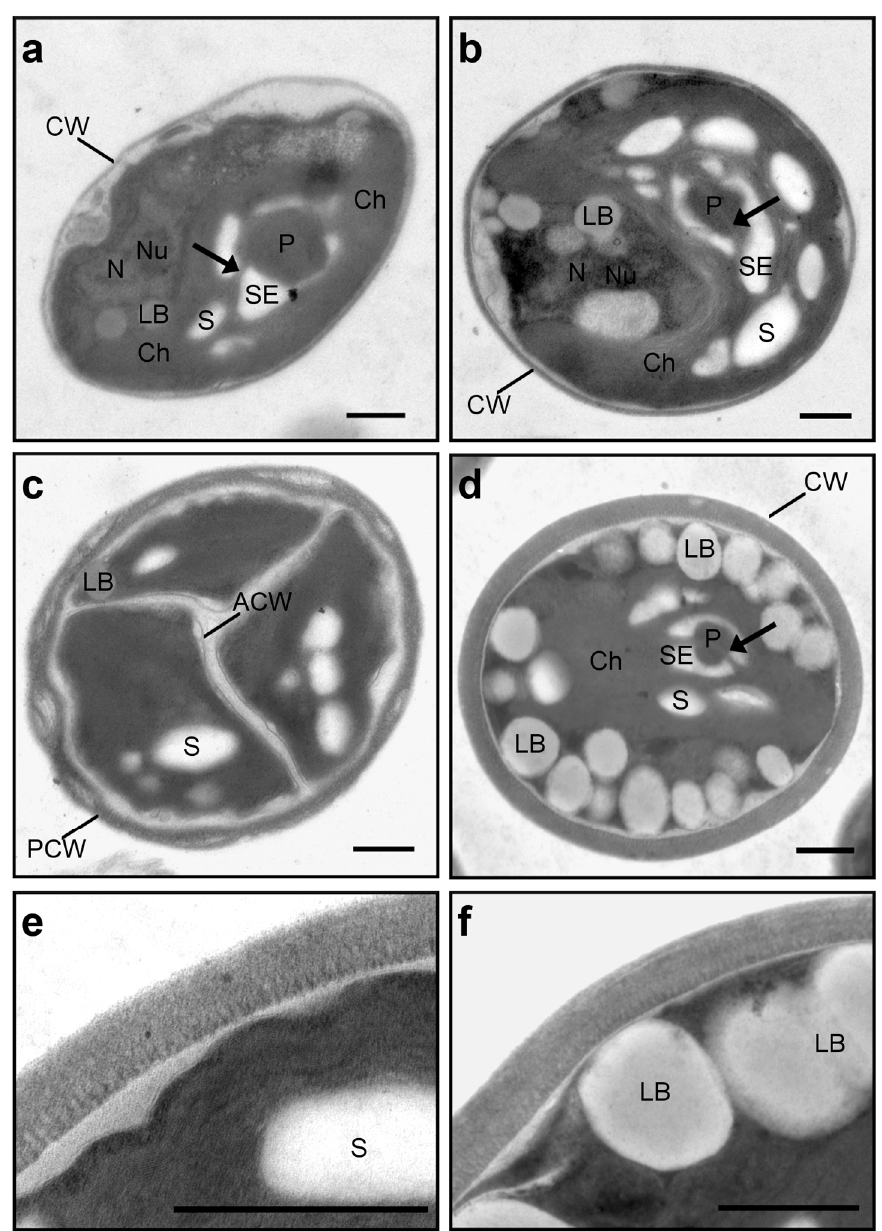
Figure 2. Cell ultrastructure of Neochlorella semenenkoi IPPAS C-1210 in exponential ( a – c ) and stationary ( d – f ) growth phases. Young ellipsoid cell with thin cell wall ( a ); mature spherical cell ( b ); parent cell with autospores ( c ); cell in stationary growth phase with thickened cell wall ( d ); and thickened cell walls of old cells ( e , f ). Ch: chloroplast; CW: cell wall; ACW: autospore cell wall; LB: lipid body; PCW: parent cell wall; N: nucleus; Nu: nucleolus; P: pyrenoid; S: starch grain; SE: starch envelope. The arrows point to the thylakoid pair penetrating the pyrenoids. Scale bars: 0.5 µm.